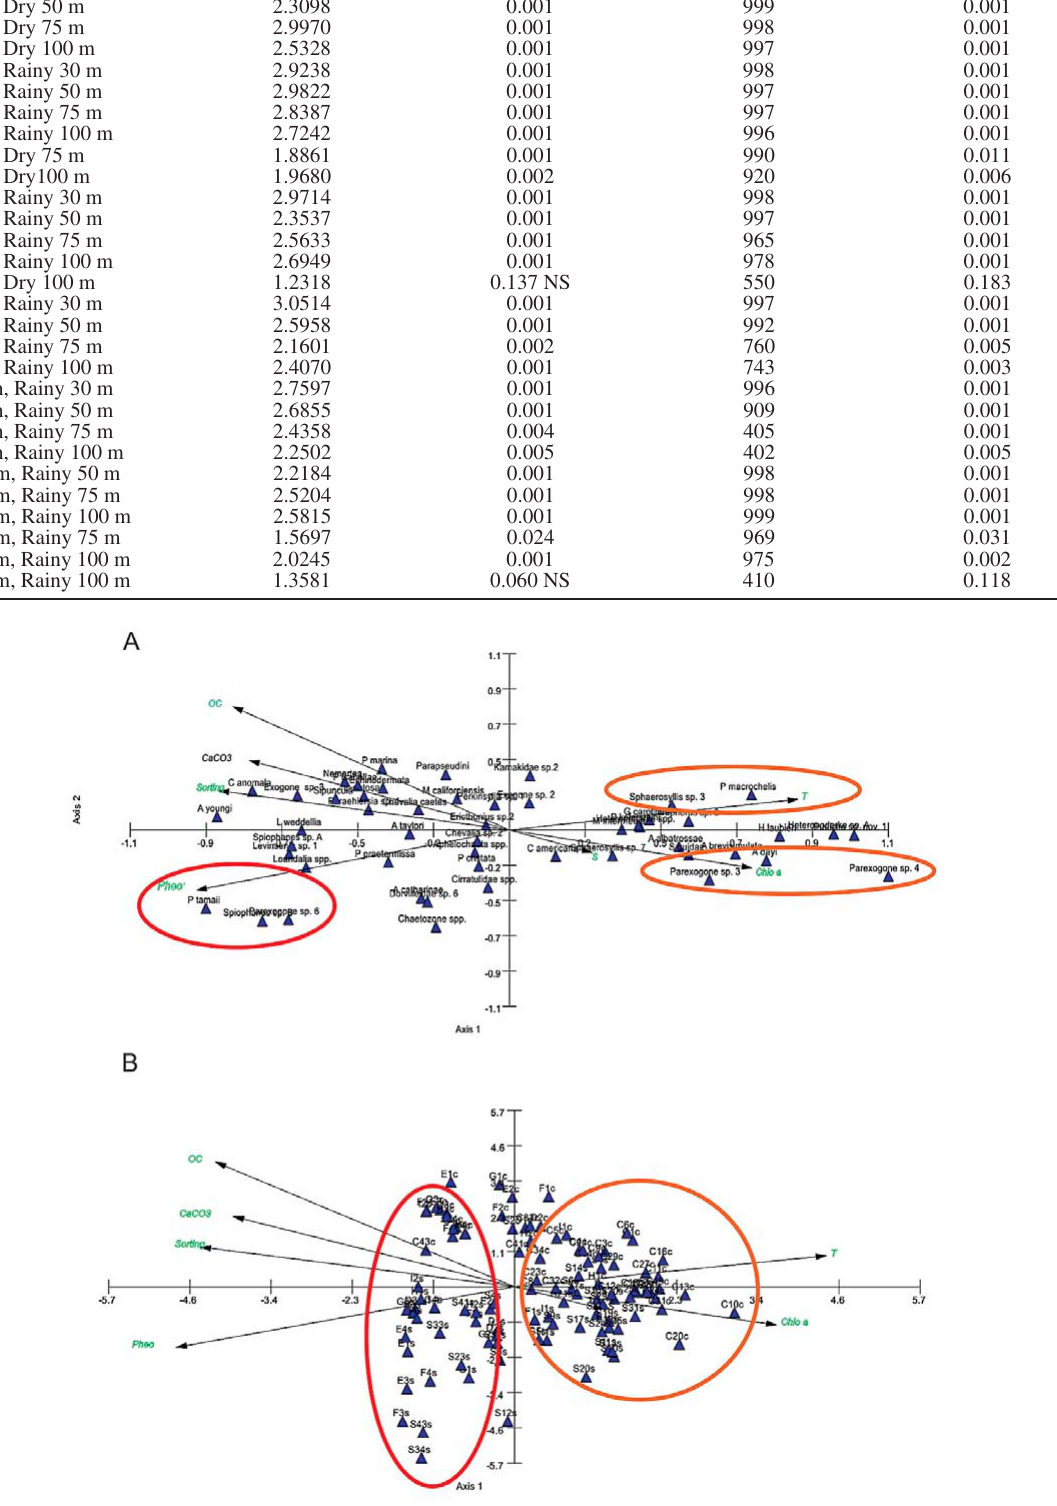
Fig. 6. – Canonical correspondence analysis of (A) the taxa with >0.5% abundance (see Table 1) vs. environmental parameters (T, temperature; S, salinity; OC, organic carbon; CaCO , total carbonate; Chl a , chlorophyll a ; Pheo, pheophytin; and sorting) and (B) the sampling stations (see 3 Fig. 1) vs. the above environmental parameters. Orange and red circles: species/environmental parameters related to shallower stations and deeper stations, respectively. Data from the 53 stations sampled during the rainy and dry periods of 2009 are shown on Appendix